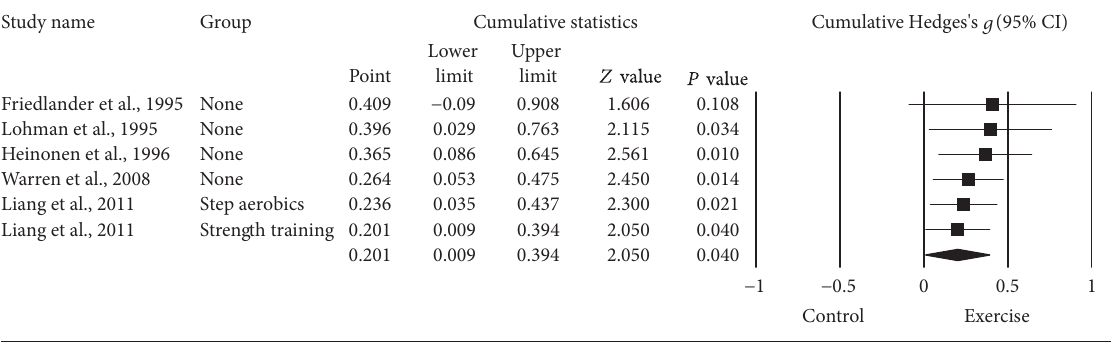
F 7: Cumulative meta-analysis for changes in LS BMD. Cumulative meta-analysis, ordered by year, for point estimate standardized effect size changes ( ) in LS BMD. e black squares represent the standardized mean difference ( squares represent the corresponding 95 con�dence intervals. e results of each corresponding study are pooled with all studies preceding it. e middle of the black diamond represents the overall standardized mean difference ( 𝑔𝑔 represent the corresponding 95 con�dence intervals. Negative results favor control groups while positive results favor exercise % %